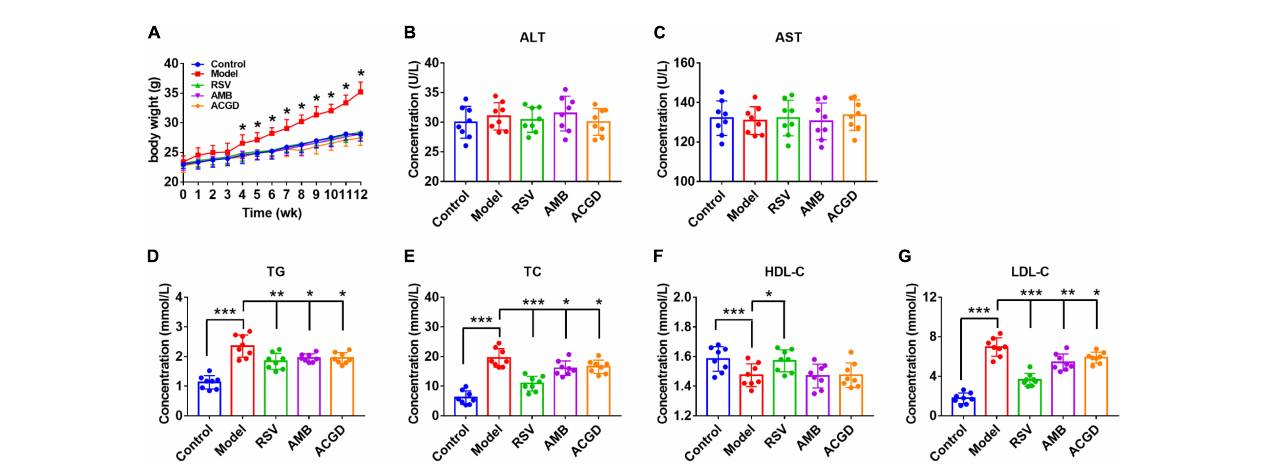
FIGURE2 Effects of the volatile oils from Allium macrostemon Bge. (AMB) and Allium chinense G. Don (ACGD) on the body weight and serum levels of biochemical indexes in mice. (A) the level of body weight; the levels of serum alanine aminotransferase (ALT) (B) , aspartate aminotransferase (AST) (C) , triglyceride